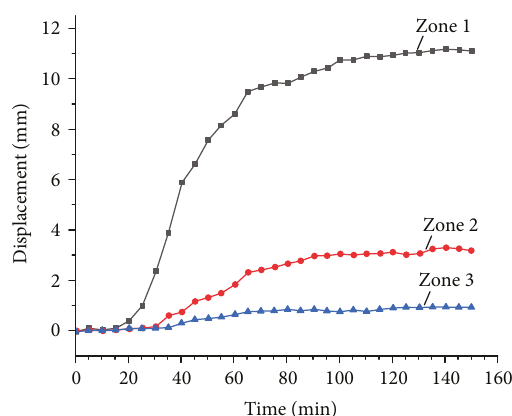
Figure 8: Average displacements of monitoring points in the three zones versus